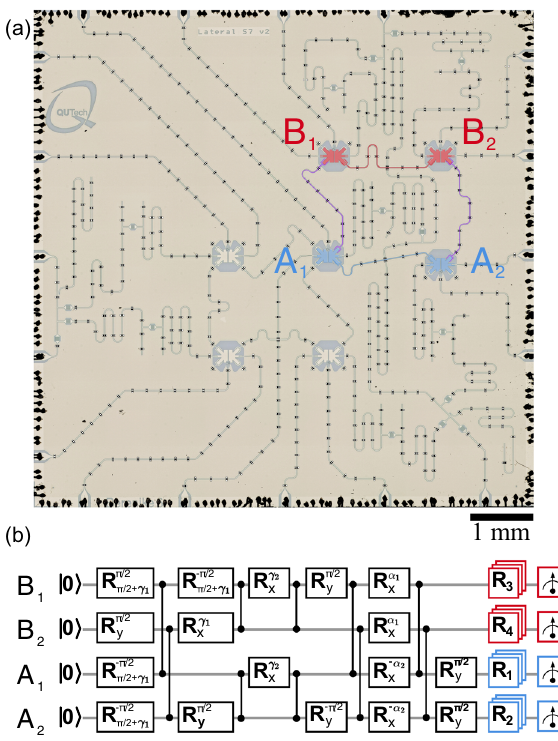
Fig. 2 Device and optimized quantum circuit. a Optical image of the transmon processor was used in this experiment, with false color highlighting the four transmons employed and the dedicated bus resonators providing their nearest-neighbor coupling. Scale bar corresponds to 1 mm. b Optimized circuit equivalent to that in Fig. 1 ( b ) and conforming to the native gate set in our architecture. All variational parameters are mapped onto rotation axes and angles of single-qubit gates. Tomographic pre-rotations R 1 – R 4 are added to reconstruct the terms in the cost function C and to perform two- qubit state tomography of each system following end of the circuit to fi rst extract all the terms in the cost function C